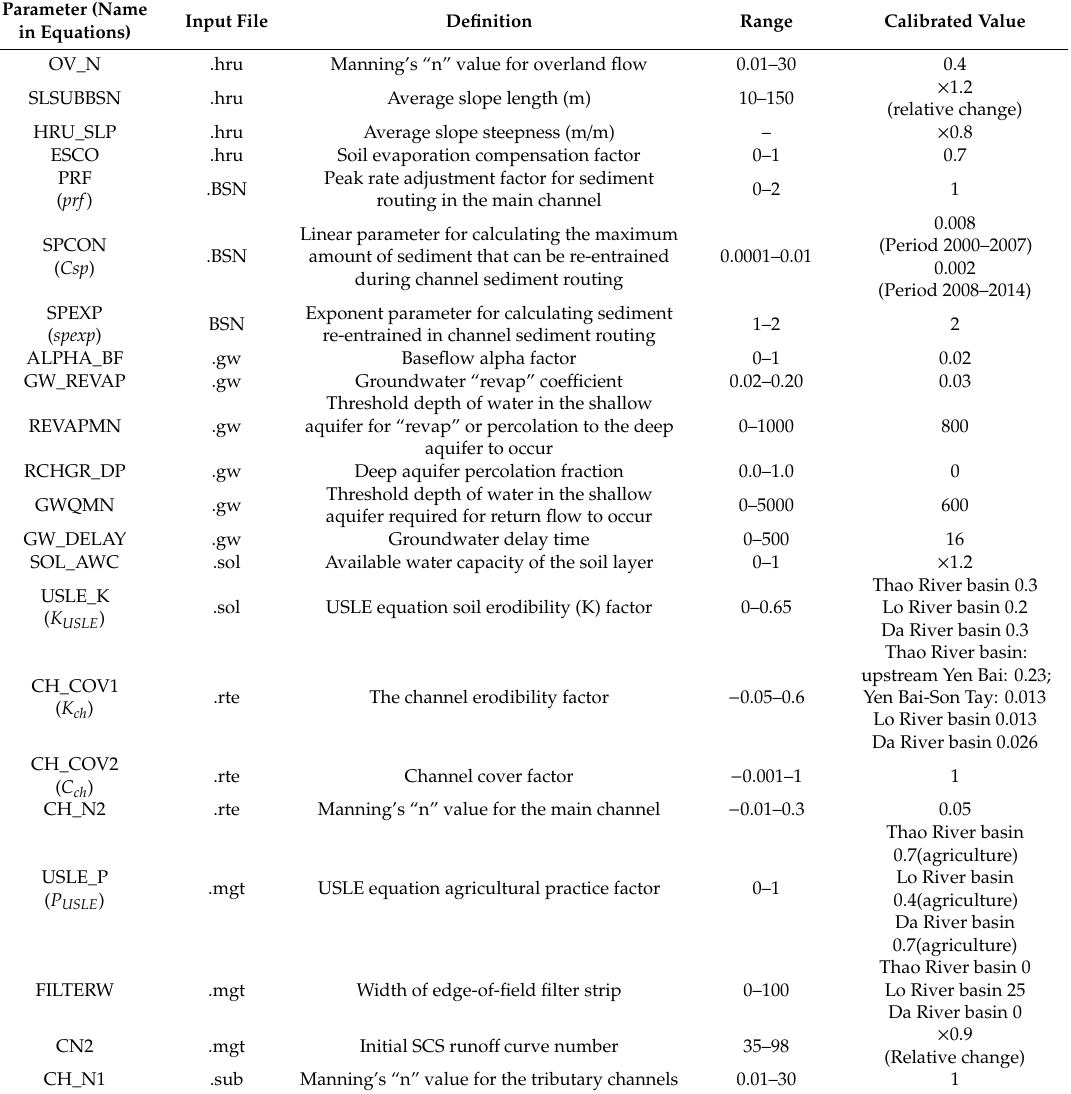
Table 4. Parameters Used to Calibrate Flow and Suspended Sediment Concentration for Di ff erent